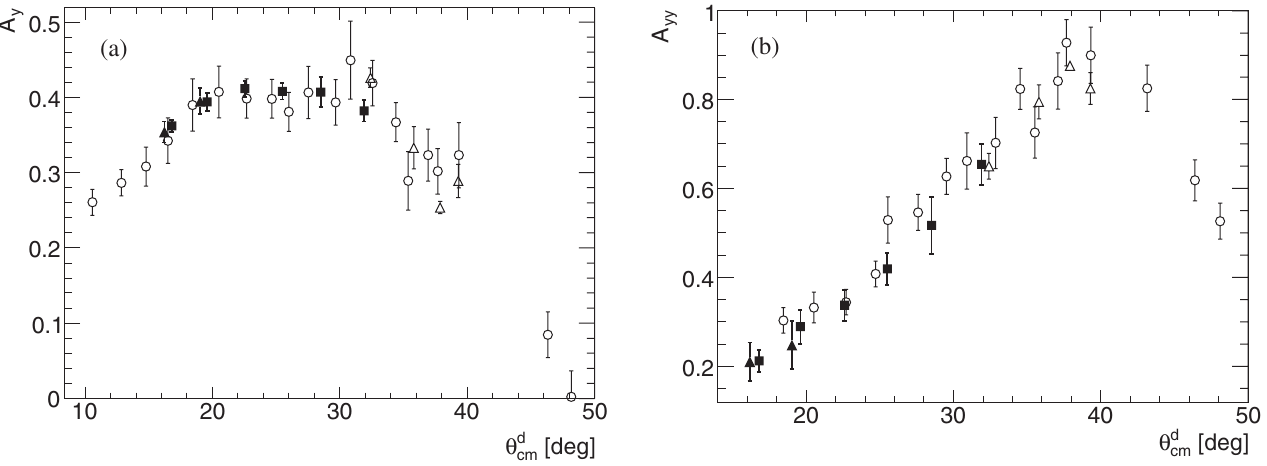
FIG. 13. Vector (left panel) and tensor analyzing powers (right) for elastic deuteron-proton scattering at small forward angles. Our data at 1170 MeV (solid squares) were obtained using information solely from the forward detector system whereas two points (solid triangles) resulted from coincidence measurements with the silicon telescope (for numerical values, see Table II). These data are compared to the results from Argonne at 1194 MeV [47] (open circles) and SATURNE at 1198 MeV [12] (open triangles). It should be noted that the tensor beam polarization at SATURNE was the subject of a series of very careful calibrations